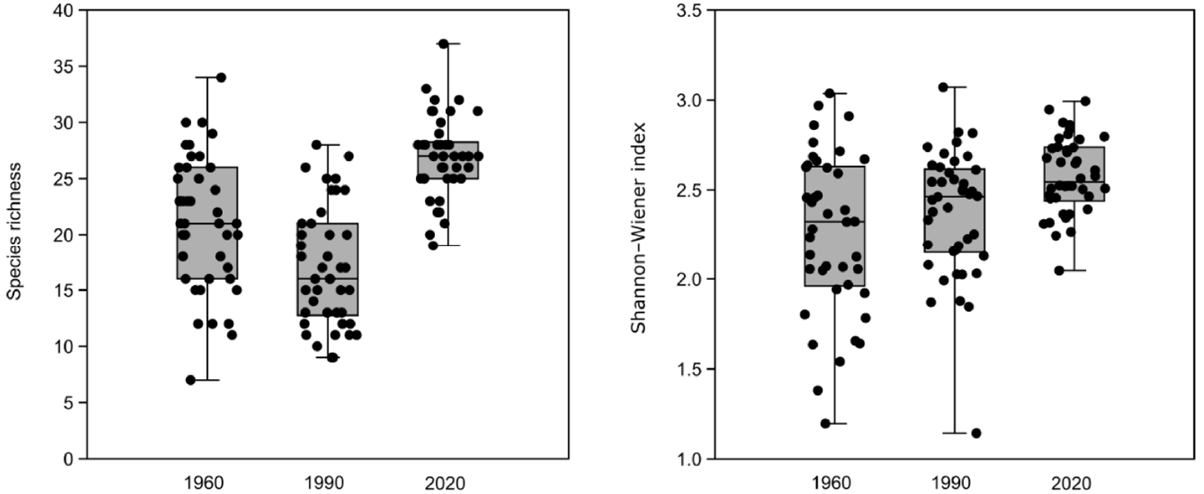
Figure 2. Summary box-and-whisker plots with jitters of forest floor species richness and Shannon–Wiener Index, for three survey dates of riparian forest in the Odra River Valley (SW Poland). The central line of each box indicates the median value, box boundaries the lower (25%) and upper (75%) quartiles, and whiskers the range of